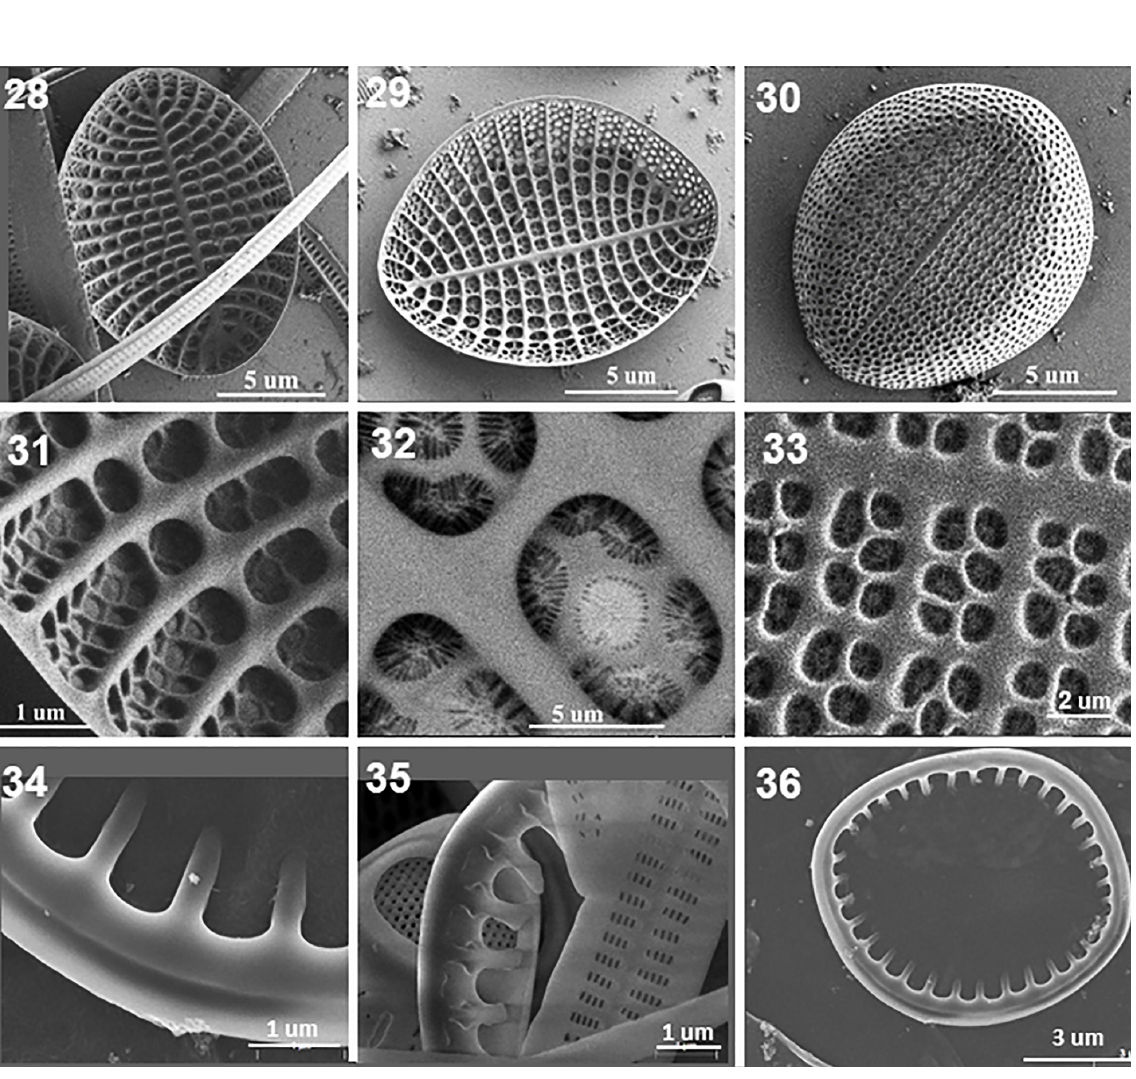
Figs 28–36. SEM images of C. vrangoensis Al-Handal & Riaux-Gob. sp. nov. (BGBM, slide B 40 0043105). 28–29 . Internal view of the SV. 30 . External view of the SV. 31. Enlarged section of the marginal part of showing areola structure. 32 . Areolae occluded by hymenes, internal side. 33 . Radial arrangement of areolae, external side. 34 . Advalvar side of the valvocopula showing shape of fimbria. 35 . Abvalvar side of valvocopula. 36 . Closed and strong valvocopula with